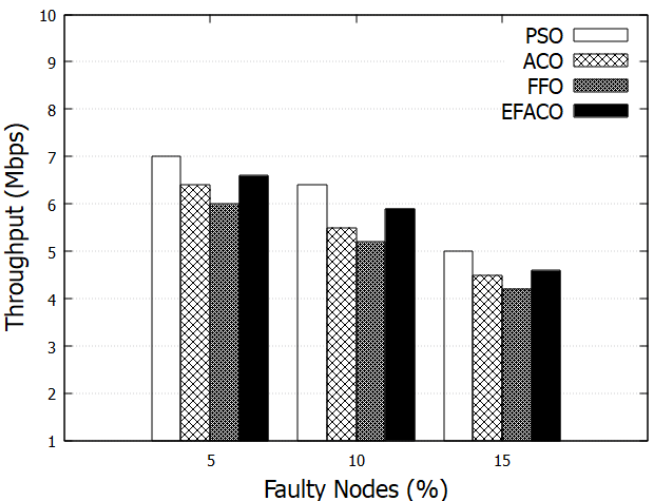
Figure 5. Comparison between proposed PSO, ACO, FFO, EFACO for throughput with faulty